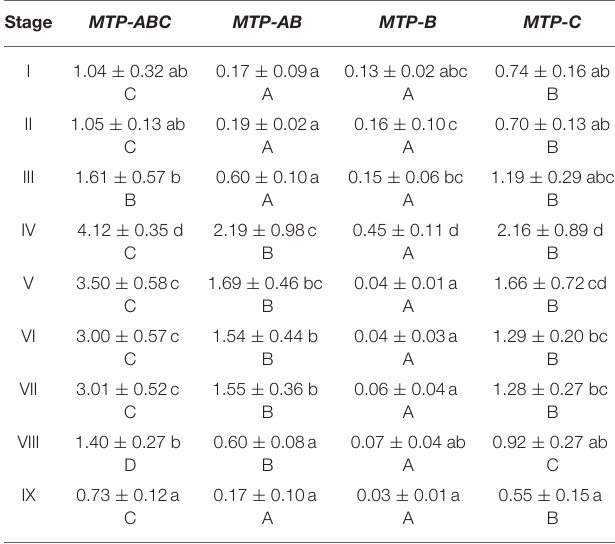
TABLE 4 | Expression levels of MTP transcripts during embryo